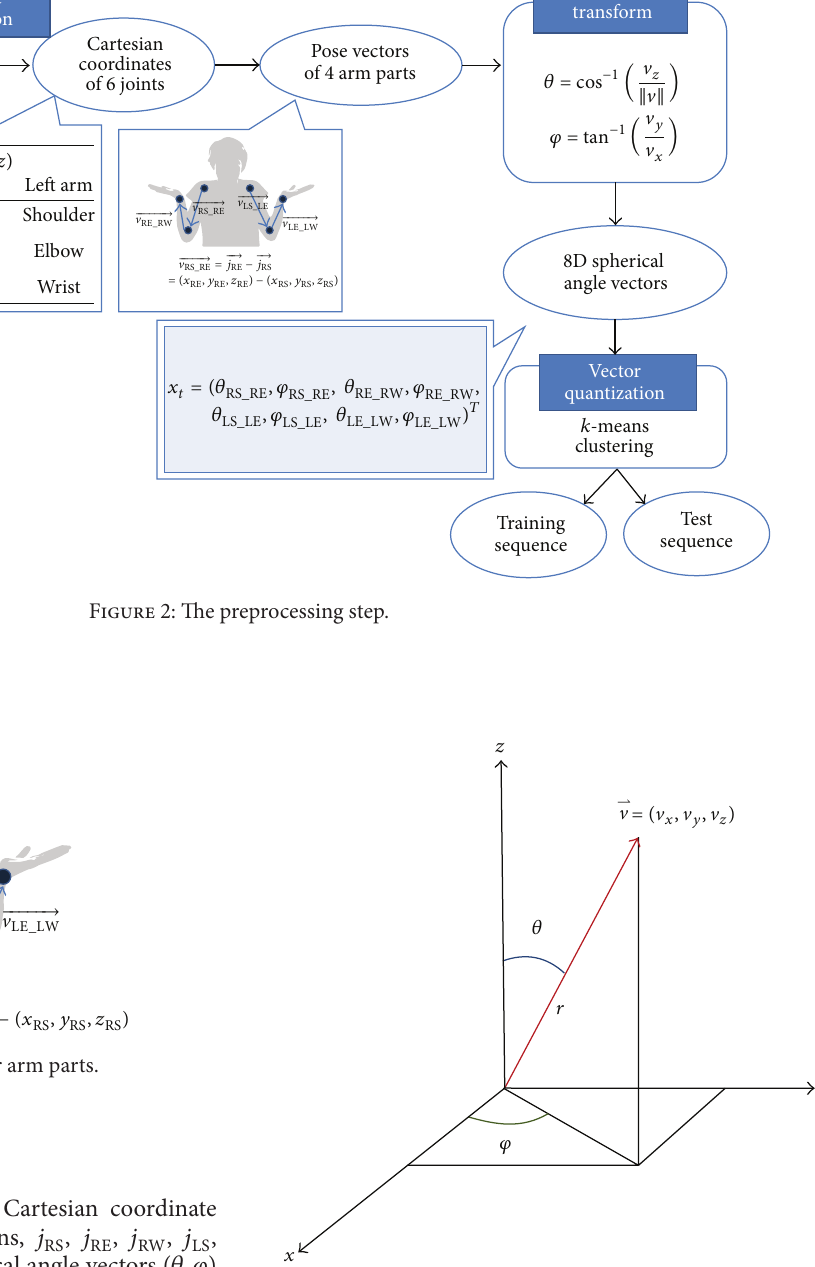
Figure 4: Transformation of pose vector ( V 𝑥 , V 𝑦 , V 𝑧 ) into spherical angle vector (𝜃, 𝜑)